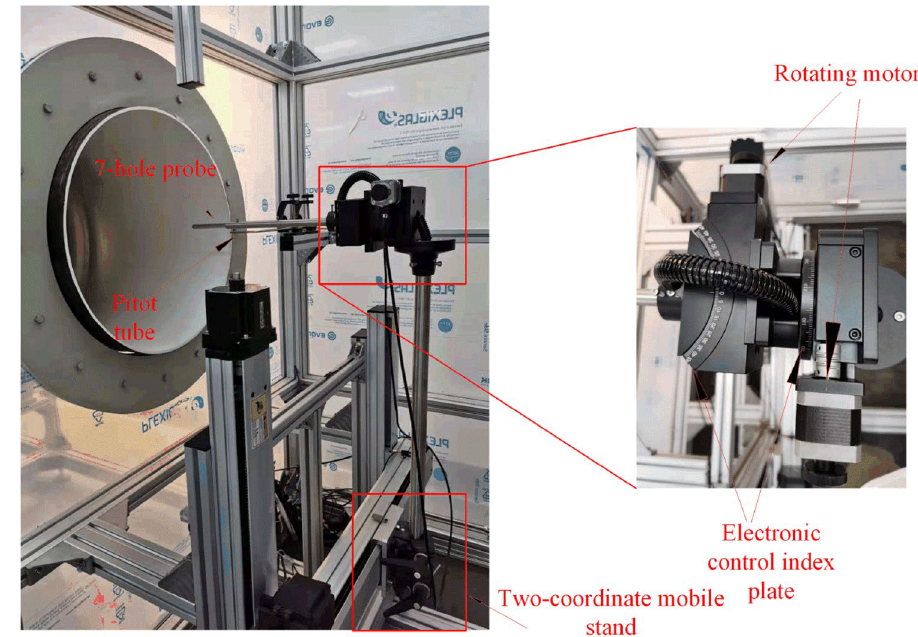
Figure 5. Two-coordinate mobile calibration